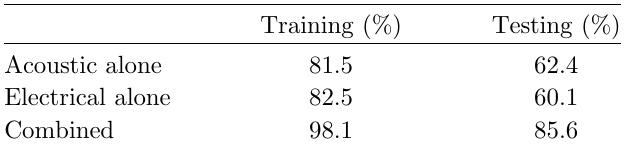
Table 1. Deep learning performance of the fracture image framework.